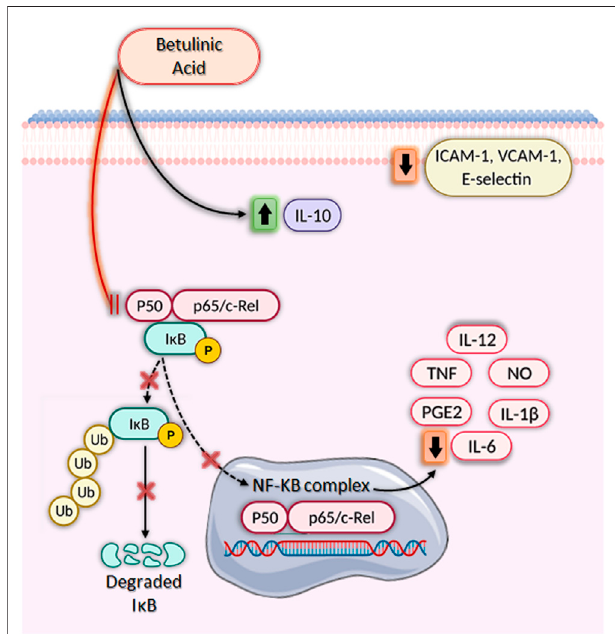
FIGURE 2 | Immunomodulatory activities of betulinic acid in vitro . Betulinic acid (BA) has a broad-spectrum anti-in fl ammatory activity, signi fi cantly increasing IL-10 production, decreasing ICAM-1, VCAM-1, and E-selectin expression and inhibiting nuclear factor kappa-light-chain- enhancer of activated B cells (NF- κ B), leading to downregulation of several pro-in fl ammatory genes. BA blocks the NF- κ B signaling pathway by inhibiting I κ B phosphorylation and degradation through ubiquitination via the proteasome degradation machinery. As a result, NF- κ B is not activated and does not translocate from the cytoplasm to the nucleus, impeding the transcription of pro-in fl ammatory mediators such as IL-1 β , IL-6, IL-12, NO, PGE2, and TNF. Created with